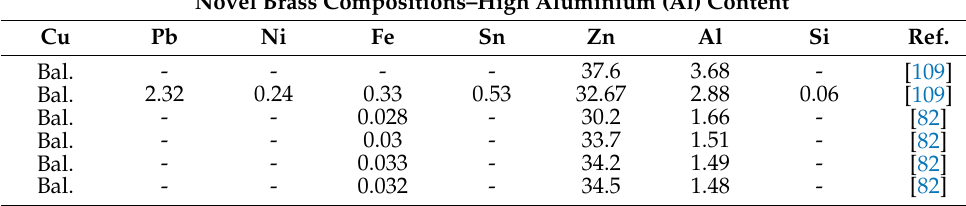
Table A3. Novel brass compositions with an increased aluminium (Al) content (alloying elements expressed in wt.%).